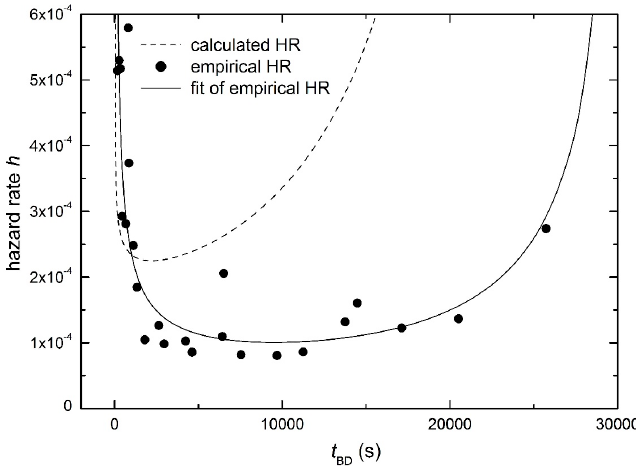
Figure 2. Hazard rate (see Equation (17)) for the CDF (W4) of the time-to-breakdown of Hf-doped Ta 2 O 5 /SiO 2 capacitors under stress voltage − 4.5 V at the temperature of 80 ◦ C [8], where the distribution parameters are determined by the LSM of the Weibull plot in Figure 1 (dashed line). Empirical HR is added (full circles) with its fit using Equation (17) (solid line).